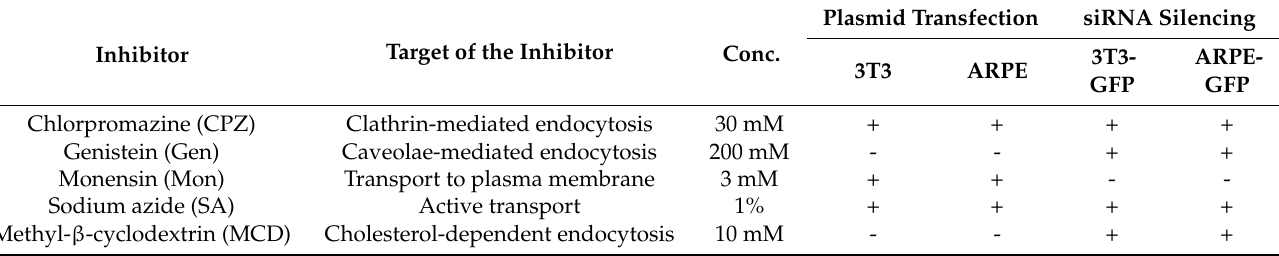
Figure 6. In vitro GFP silencing with siRNA against GFP transcripts. ARPE-GFP cells ( A ) and 3T3-GFP cells ( B ) were transfected with siRNA against GFP transcripts, using GenMute and TE- PA-BCD as transfection reagents. Control groups are nontreated cells. The symbol * indicates p < 0.05 comparing TEPA-BCD to control and GenMute using ANOVA at 48 h. Error bars represent the standard deviation from 8 images.